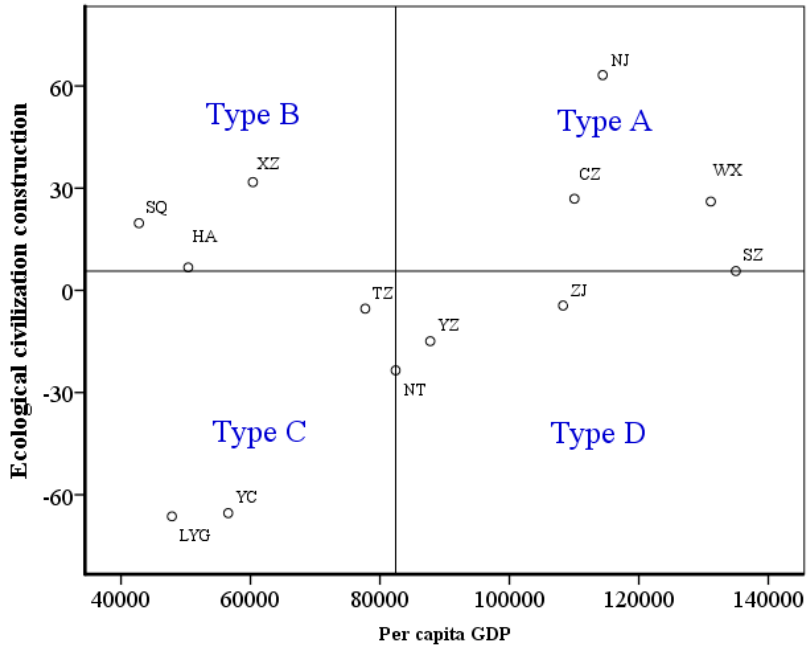
Figure 8. Relationship between ecological civilization level and per capita GDP in Jiangsu Province.